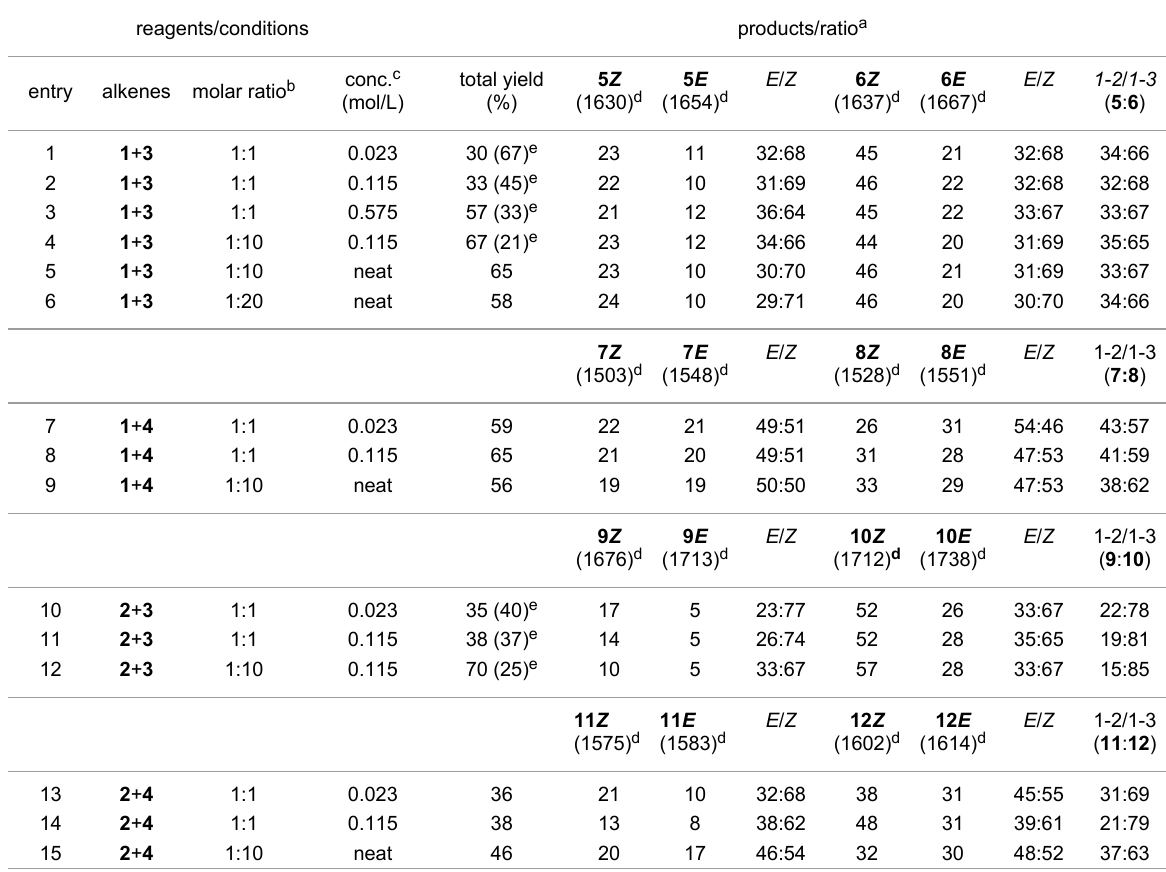
Table 1: Results of ROCM reactions of nitriles 1 and 2 with olefins 3 and 4 .